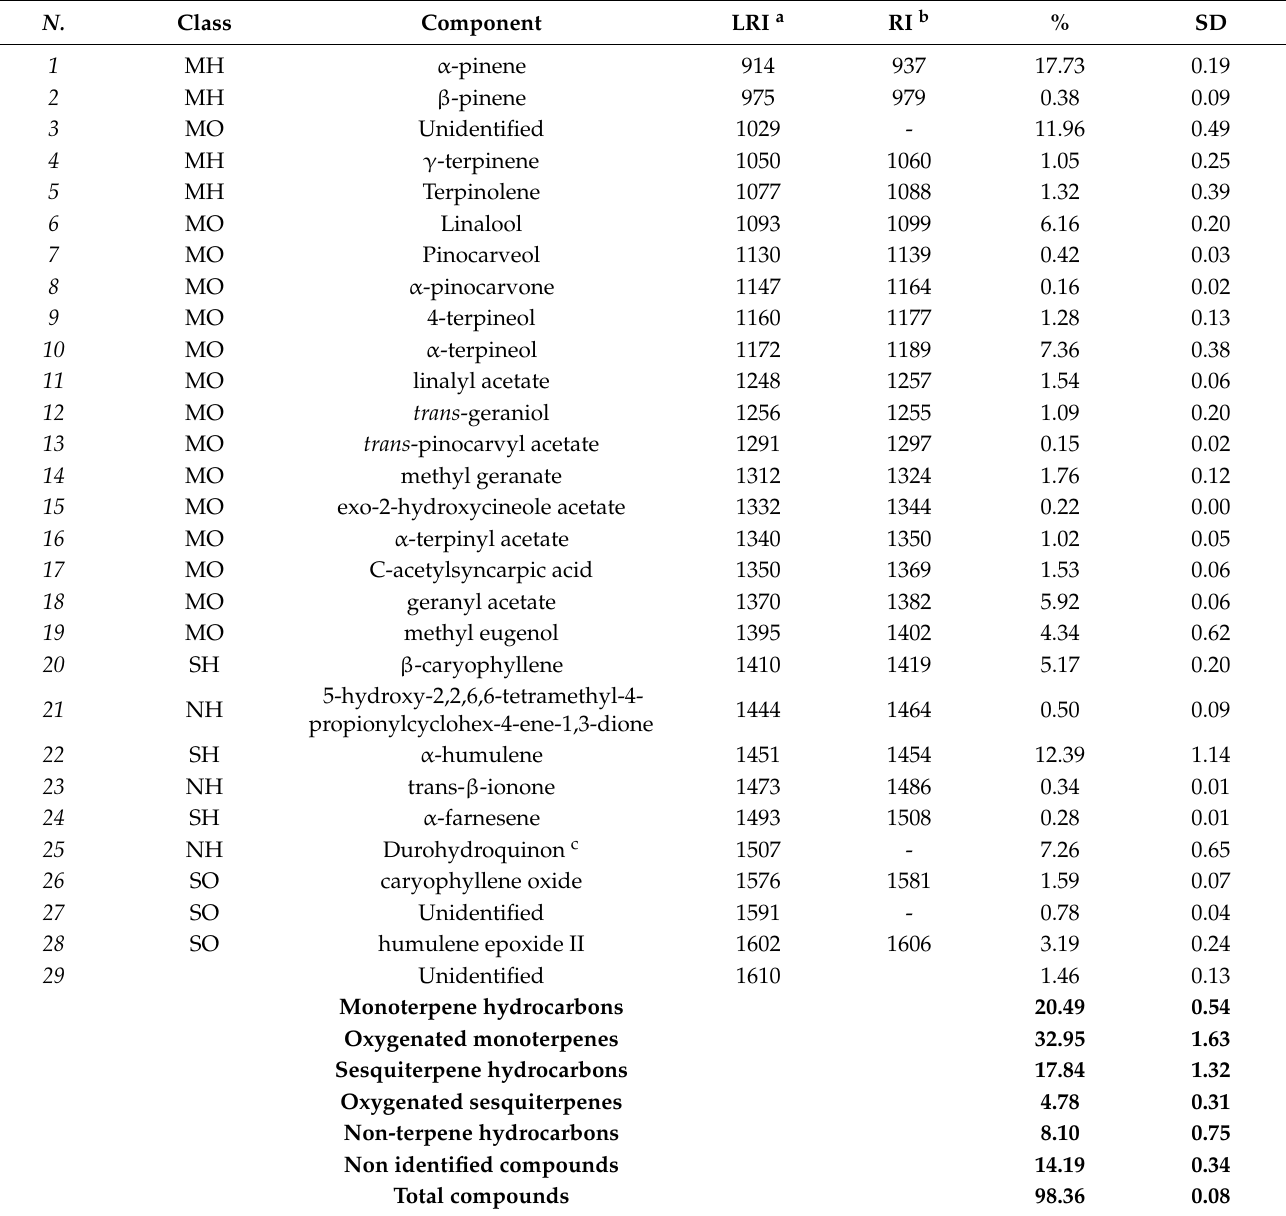
Table 1. GC-MS profile of the leaf essential oil of Myrtus communis subsp. tarentina